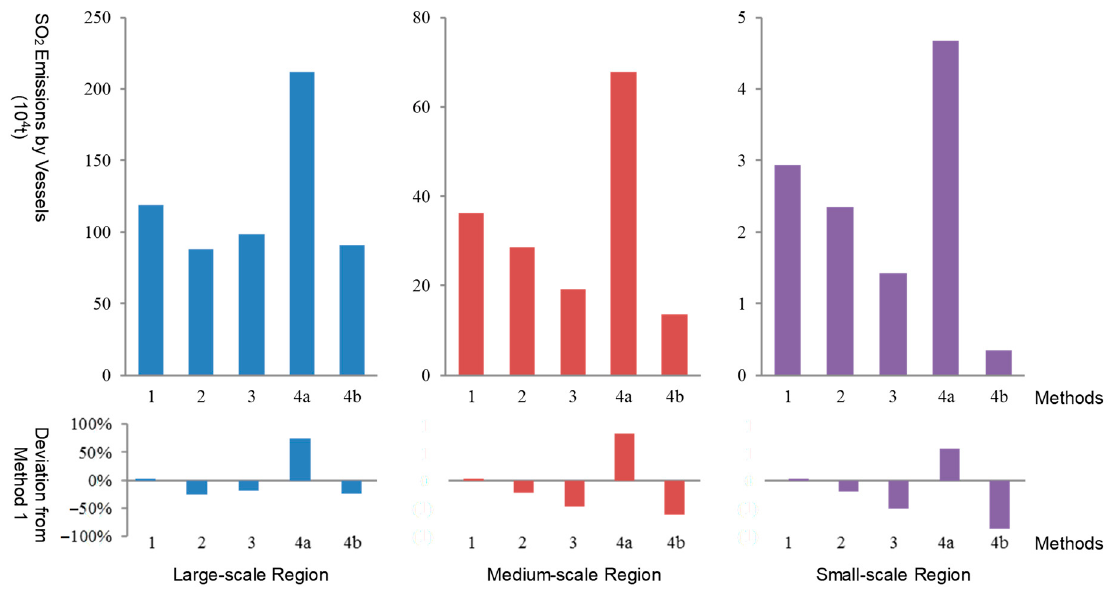
Figure 7. Comparison chart of illustrative computed results by each method.